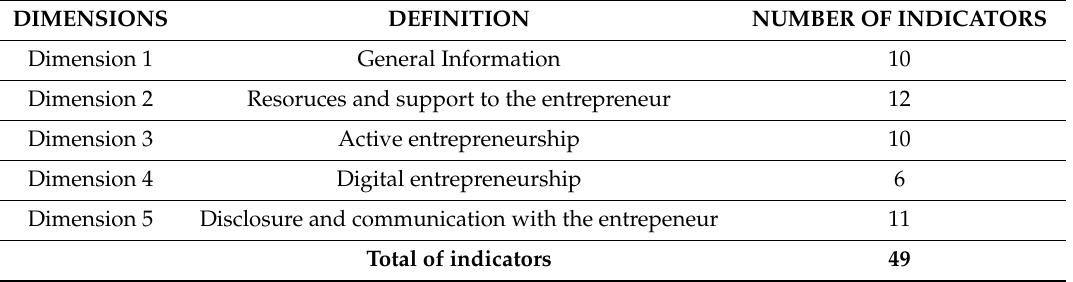
Dimensions for the assessment of the indicators from the disclosure index (source: Carvalho et al.